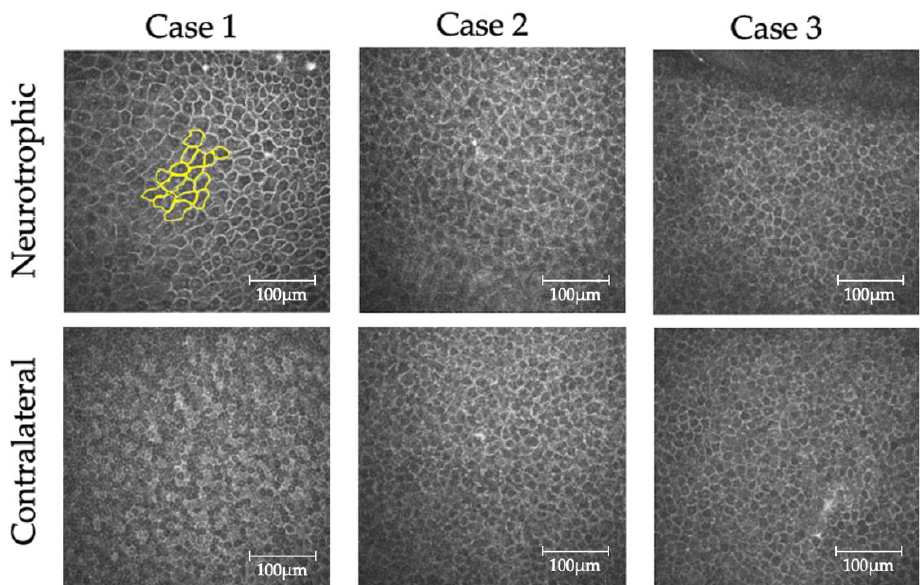
Figure 4. Observation of basal cells by in vivo confocal microscopy. Fifteen cells per photo were